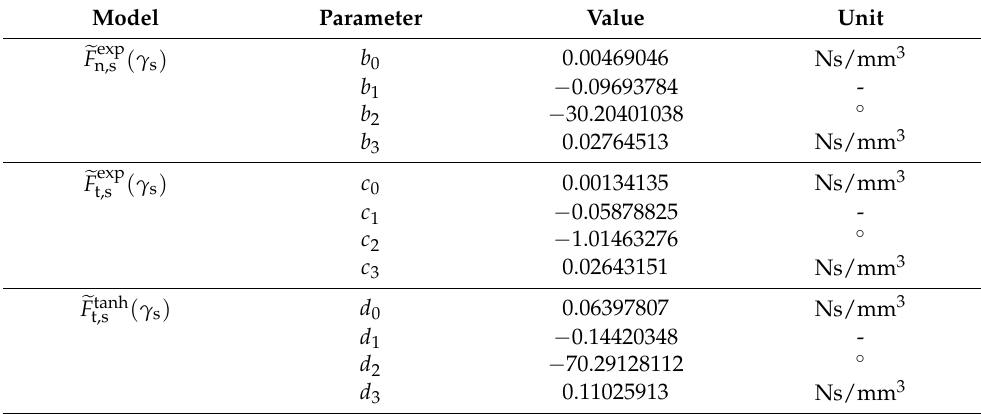
Table 4. Optimal force model coefficients based on results of the parameter study.